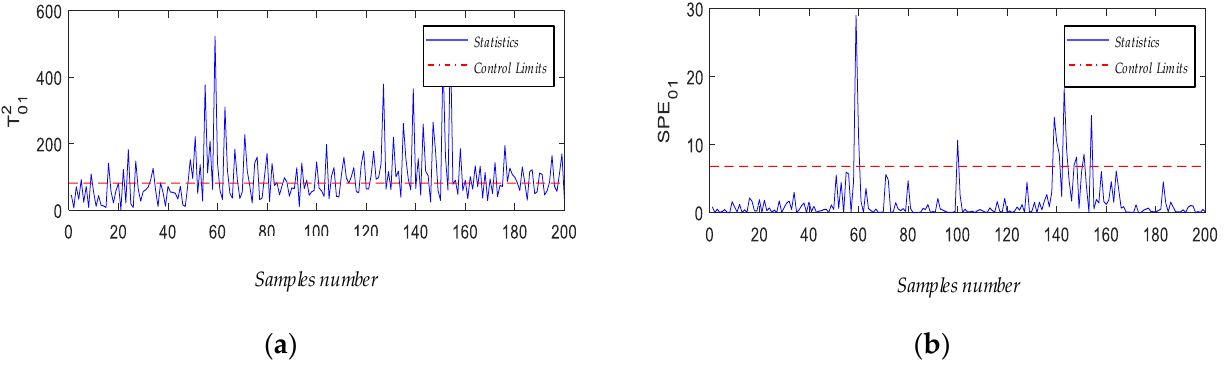
Figure 8. Experimental results of I-PCA fault detection method for the rolling bearing outer ring: ( a ) the result of T 2 ; ( b ) the result of SPE 01 .